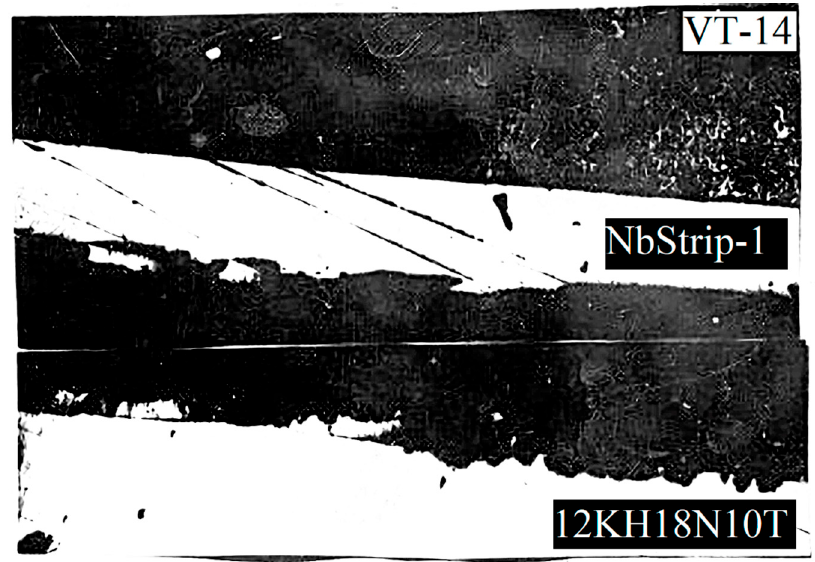
Figure 10. View of the destroyed sample after testing.